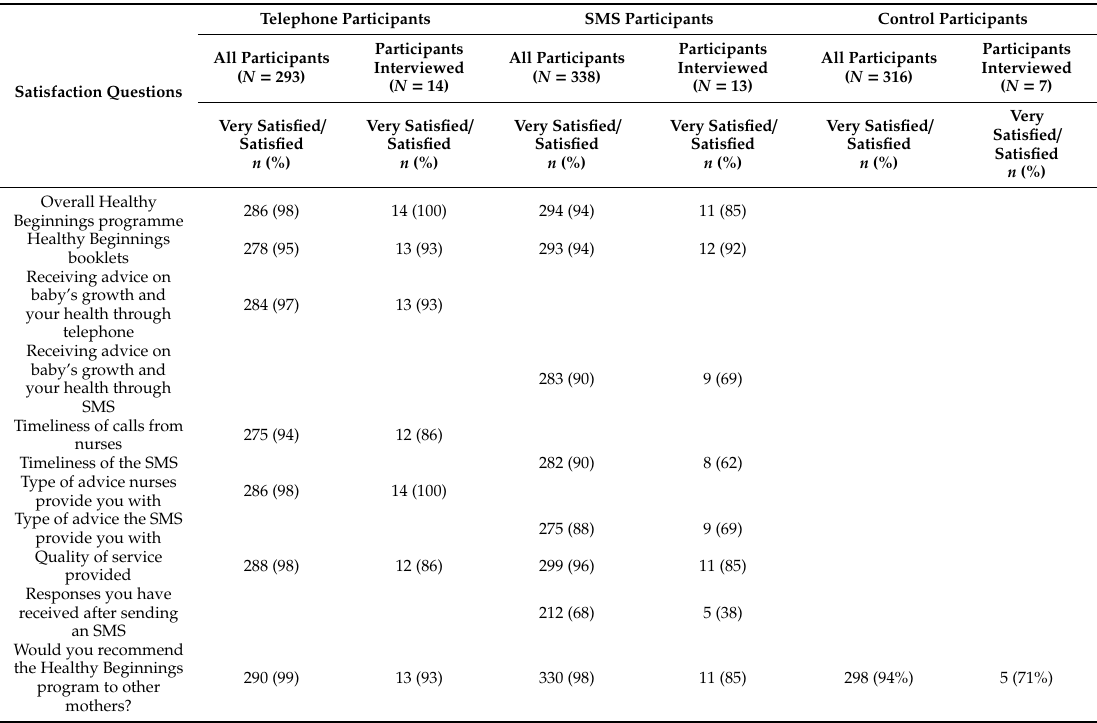
Table 3. Aggregate participants’ responses to satisfaction questions at the six-month survey.